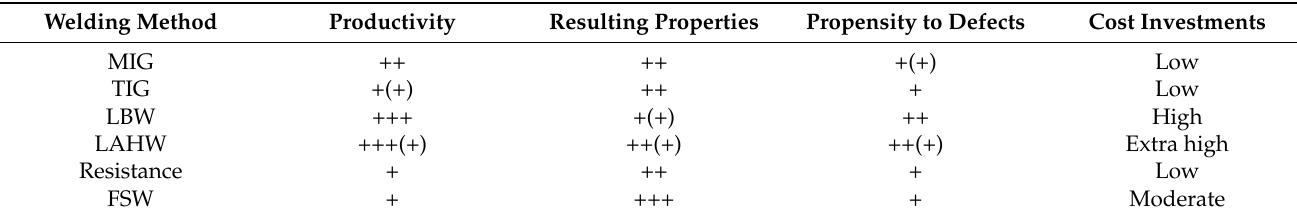
Table 2. Comparison of different common welding methods for aluminium alloys. (Sign representation: + is low level, ++ moderate level, and +++ high level) [30,38–40]. Welding Method Productivity Resulting Properties Propensity to Defects Cost Investments